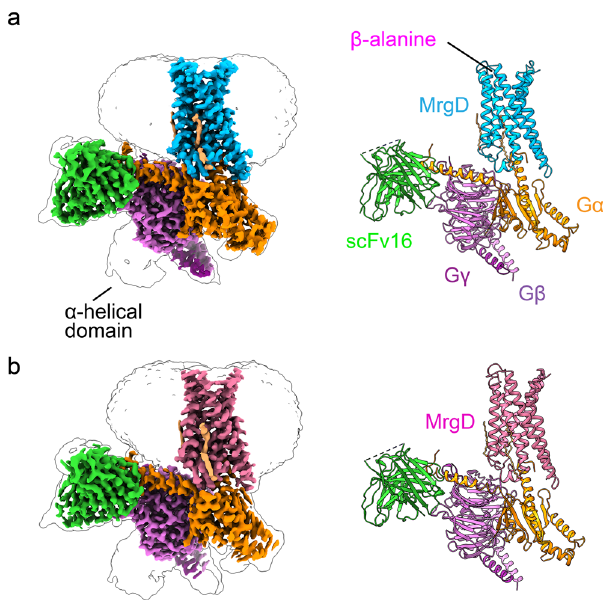
Fig. 1 Overall structure of the MrgD – Gi complex. a β -alanine-bound state of the MrgD – Gi complex. b apo state of the MrgD – Gi complex. The orthogonal views of the cryo-EM density map (left) and the built ribbon models (right) are shown. β -alanine-bound MrgD is in cyan, and Apo-MrgD is colored in red. β -alanine is shown in magenta, and palmitic acid is light yellow. The Gi heterotrimer is color-coded by subunits: Gi is in orange, G β in orchid, G γ 2 in purple, and scFv16 in green. The color scheme of the model is consistent with the density